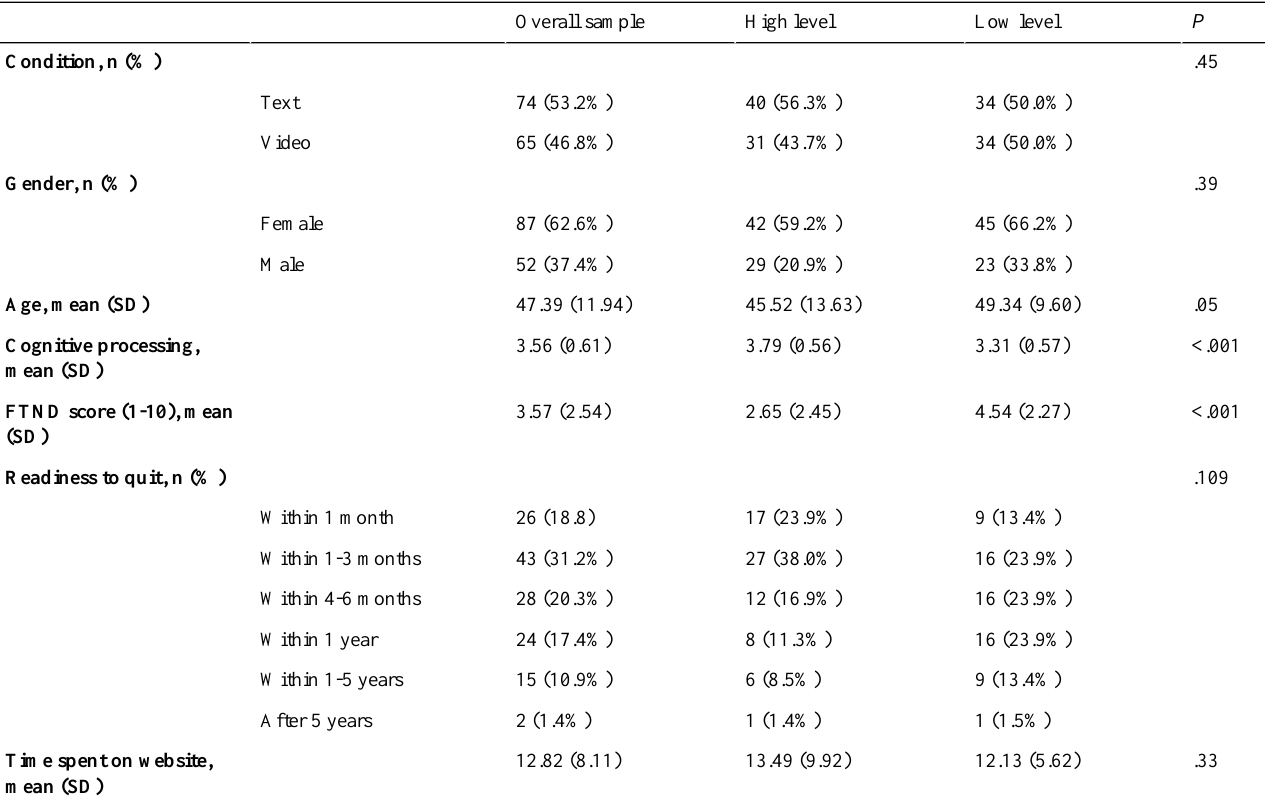
Table 2. Differences of characteristics between lower and higher educational levels (N=139).